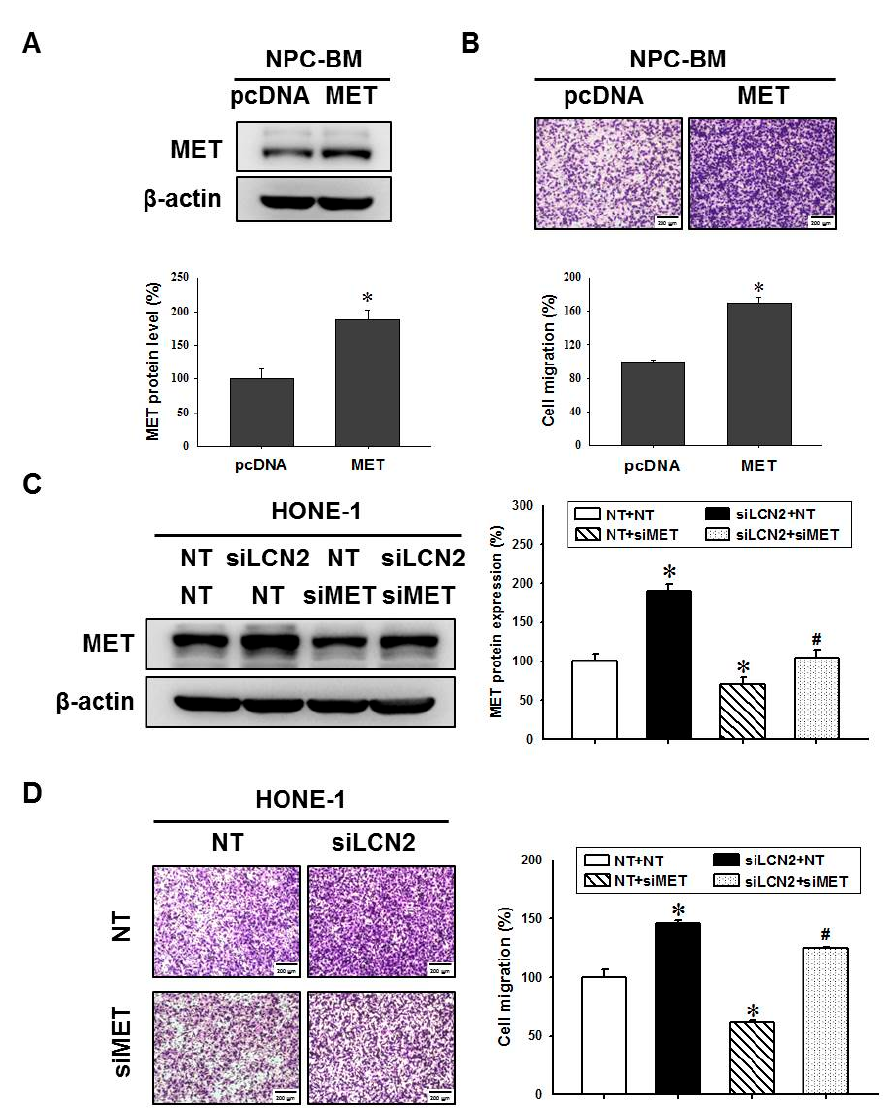
Figure 5. LCN2 decreased cell migration by reducing MET levels in human NPC cells. NPC-BM cells were transfected with control plasmids (pcDNA) or plasmids containing MET (MET) pcDNA and then subjected to Western blot analysis ( A ) or cell migration analysis ( B ). * p < 0.05 compared with control. HONE-1 cells were transfected with siRNA against LCN2 (siLCN2), MET (siMET) or control (NT) and then subjected to Western blot analysis ( C ) or cell migration analysis ( D ). * p < 0.05 compared with control. # p < 0.05 when compared with HONE-1 cells that were transfected with siMET.